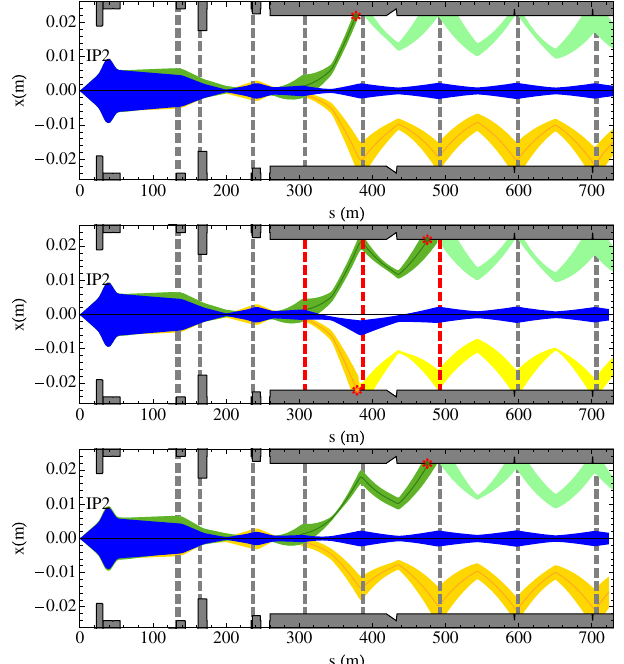
FIG. 20. (Color) Horizontal physical aperture and 6 (cid:1) envelopes after IP2: with the usual flat orbit (top), with an orbit bump (middle), and with decreased dispersion (bottom). The beams are the main circulating 208 Pb 82 þ beam (blue), the 208 Pb 81 þ BFPP beam (green), and the 206 Pb 82 þ EMD2 (yellow). The vertical dashed lines show the locations of horizontal corrector magnets and those indicated in red are active (in this case, correctors called ‘‘MCBC’’ and